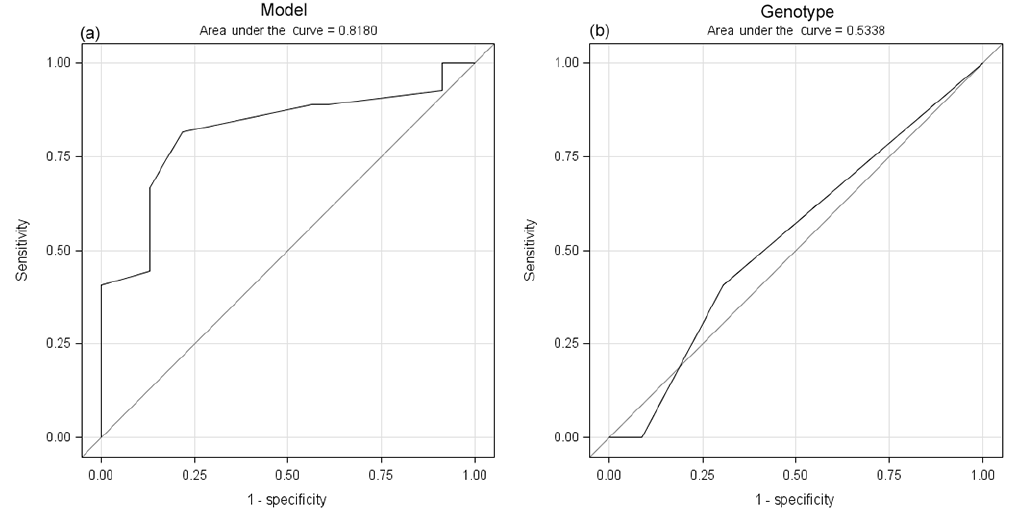
Figure 1. Receiver operating characteristic (ROC) curve analysis for the gene and the model predictive ability evaluation of meat tenderness (WBSF) in the global goose